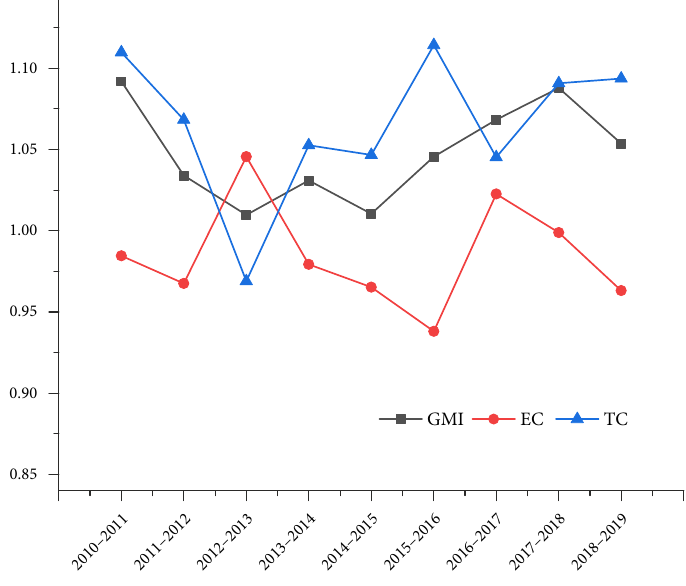
Figure 4. TC and TC in different Table 5. The EC and TC of three regions